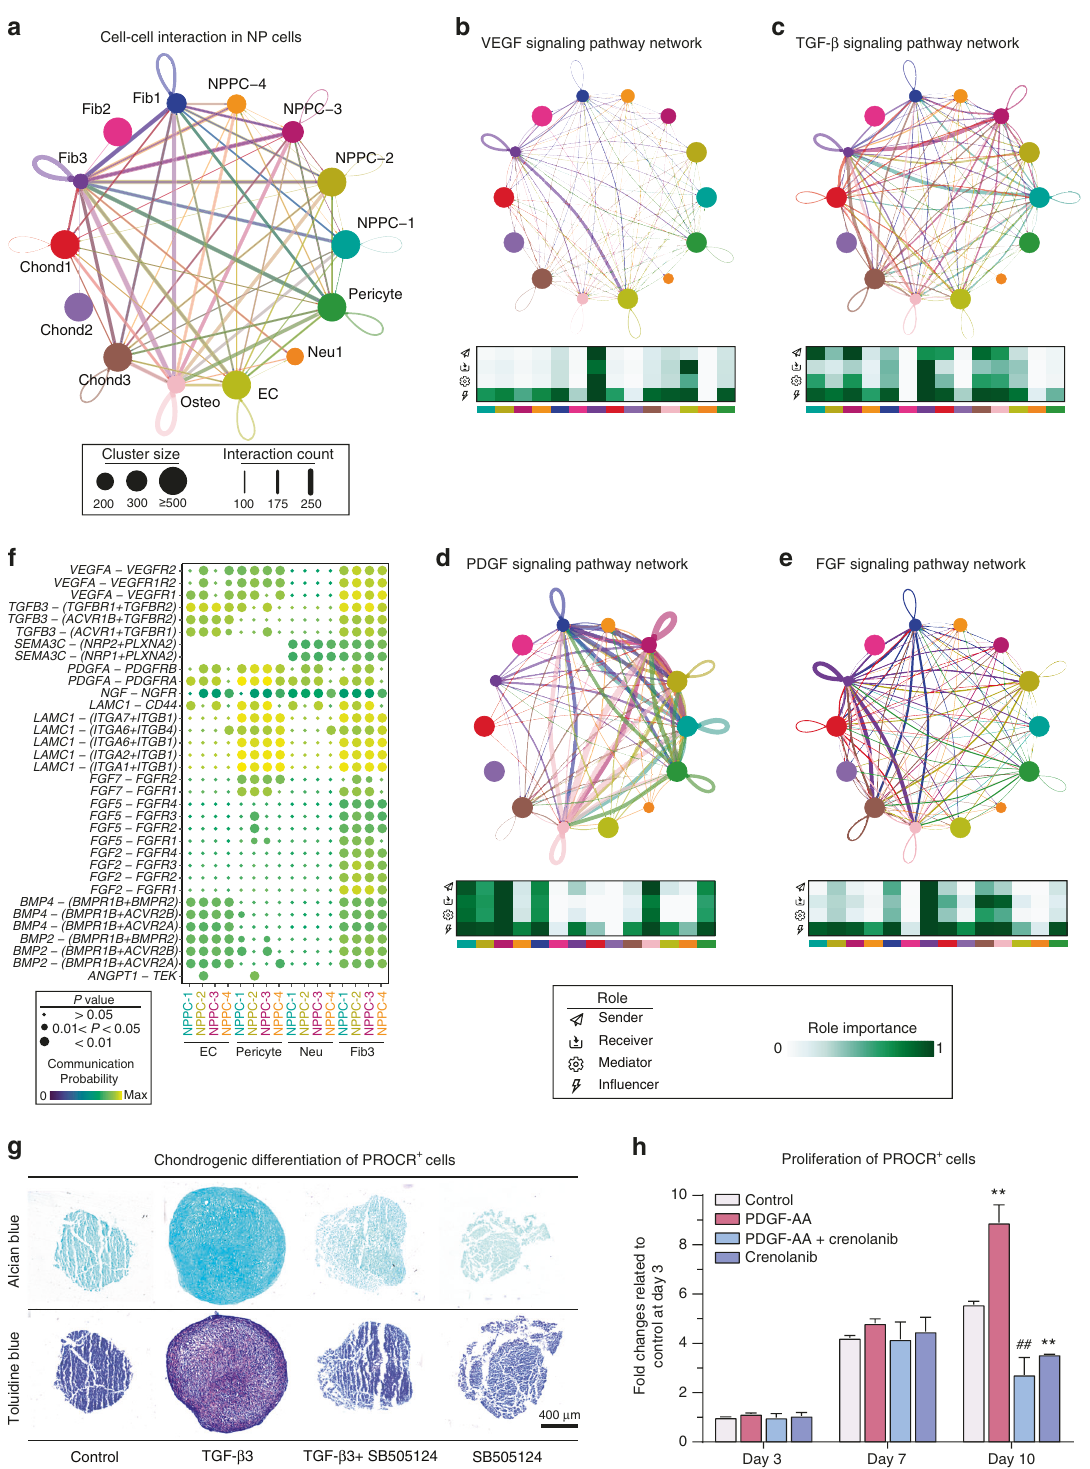
Fig. 5 Overview of the crosstalk networks among the clusters in the NP. a Overview of the cellular network regulating the homeostasis of the NP. Dots indicate cell clusters. The dot size indicates the relative quantity of each cluster. The thickness of the directed line indicates the relative quantity of signi fi cant ligand-receptor pairs between any two pairs of cell clusters. b-e Circle plots showing the inferred VEGF ( b ), TGF- β ( c ), PDGF ( d ), and FGF ( e ) signaling networks. f Dot plot showing the communication probability of the indicated ligand-receptor pairs between EC, Pericyte, Neu, and Fib3 subclusters (sending signals) and four NPPC subclusters (accepting signals). g Representative alcian blue and toluidine blue staining for the chondrogenic effect of TGF- β 3 supplementation (10 ng·mL − 1 ) for 28 days on PROCR + cells from the human IVD. Scale bars, 400 μ m. h Histogram showing the proliferation of PDGF-AA (20 ng·mL − 1 ) on PROCR + cells from the human IVD detected by a CCK-8 kit ( n = 3). The statistical signi fi cance of differences was determined using one-way ANOVA with multiple comparison tests (LSD). ** P < 0.01 compared with the control group at day 10. ## P < 0.01 compared with the PDGF-AA group at day 10. Error bars indicate the